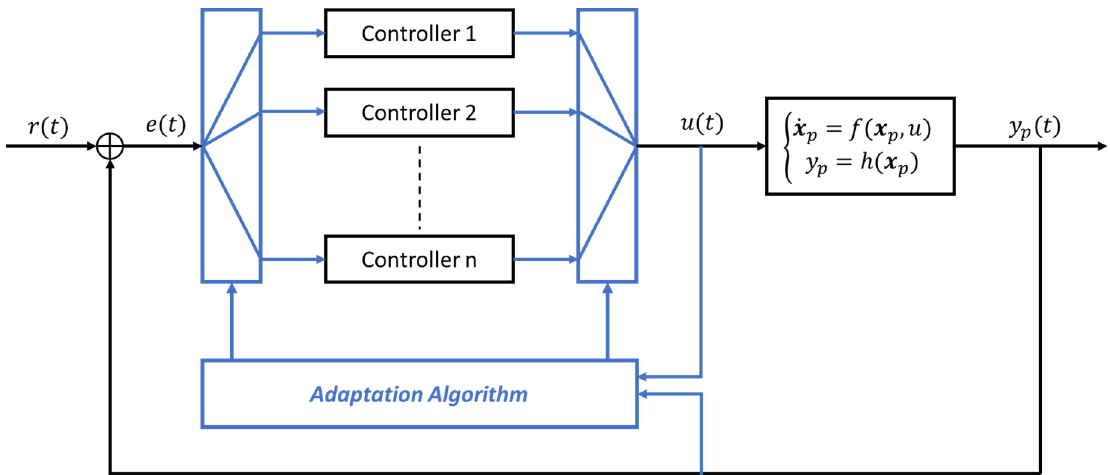
Figure 2. A single input single output (SISO) proportional-integral derivative (PID) controller with Gain Scheduling Architecture.